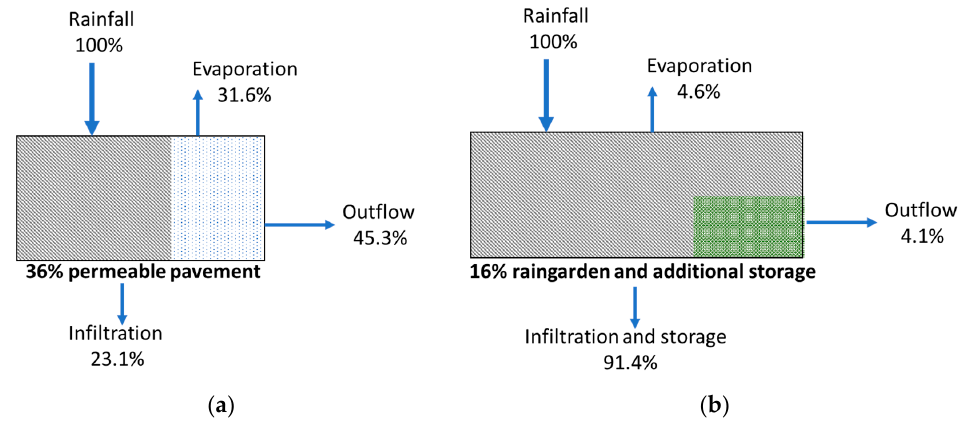
Figure 8. Annual hydrologic cycle at the two field sites. ( a ) Permeable pavement site; ( b ) raingarden site.